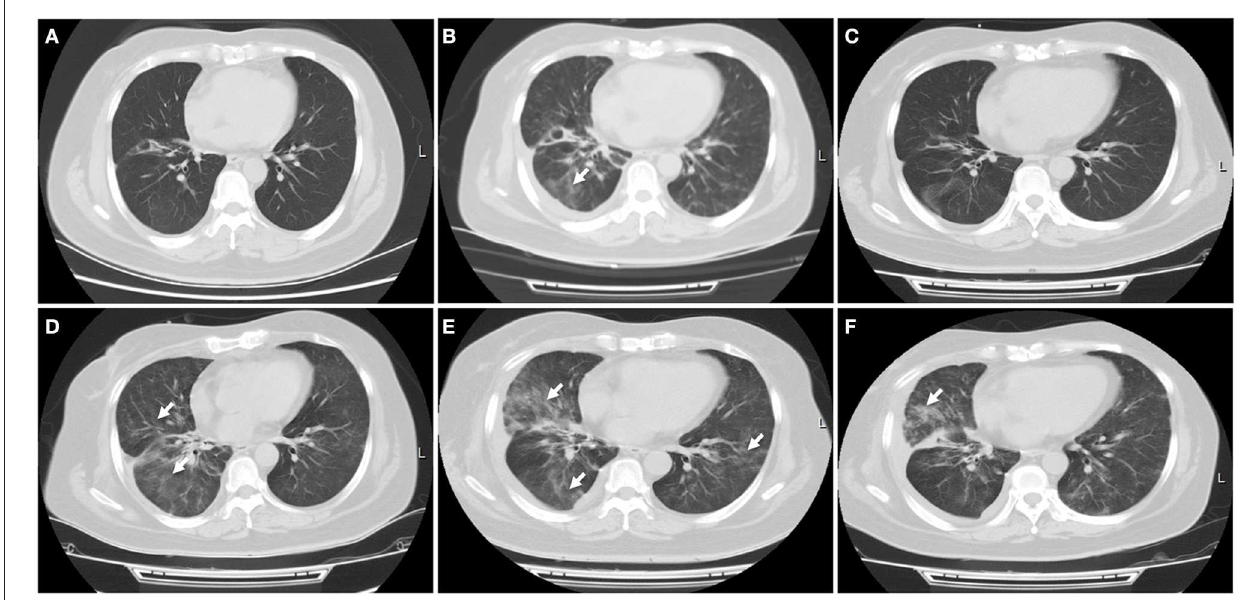
FIGURE 3 | Immune-related pneumonitis. (A) A CT scan showed no any inflammatory lesions in the lungs following the treatment with first PD-L1 inhibitor atezolizumab. (B) Nivolumab was started when this patient progressed on atezolizumab treatment. A CT scan indicated new patchy ground-grass opacities in the bilateral lungs, with a small left pleural effusion. Immune-related pneumonitis was identified when blood and sputum culture did not reveal a causative microbial organism. (C) After treatment with corticosteroid for 1 week, this patient’s symptom improved significantly, with a radiologic complete resolution of the ground-glass opacities and the pleural effusion. (D) Ten days later, a CT scan showed reoccurred pneumonitis, of grade 3 severity. (E) High-dose intravenous corticosteroid therapy did not alleviate her symptoms within 5 days, with worsening radiographic findings. (F) After she received immunosuppressive agents including infliximab, mycophenolate mofetil and human immunoglobulin, fever, dry cough, and dyspnea were relieved significantly, with a significant improvement of pulmonary inflammation. White arrow indicates inflammatory